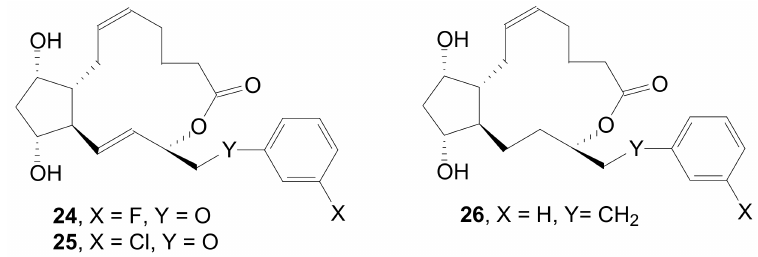
Figure 3. 1,15-Lactones of fluprostenol, cloprostenol, and latanoprost.